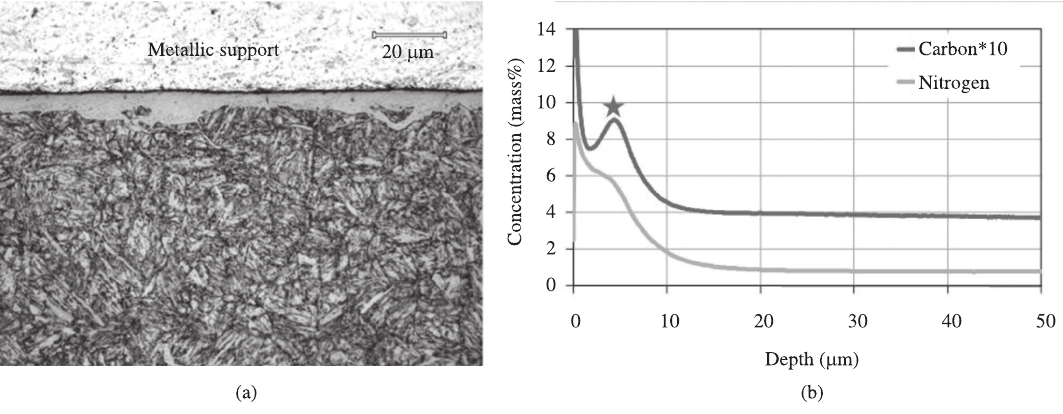
Figure 5. Sample CH -6h. In (a) photomicrography of the cross section of the sample and in (b) GDOES profile. 4